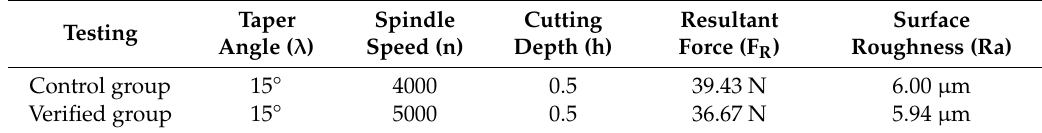
Table 8. Verification testing for resultant force (F R ) and surface roughness